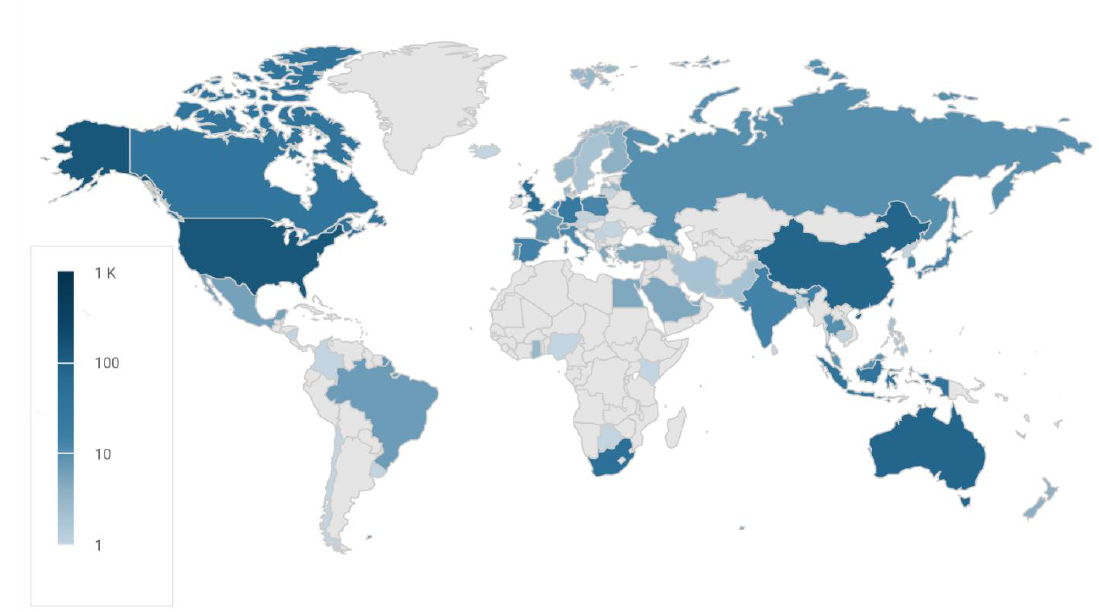
Figure 7. Demographic distribution of publishers and number of publications .